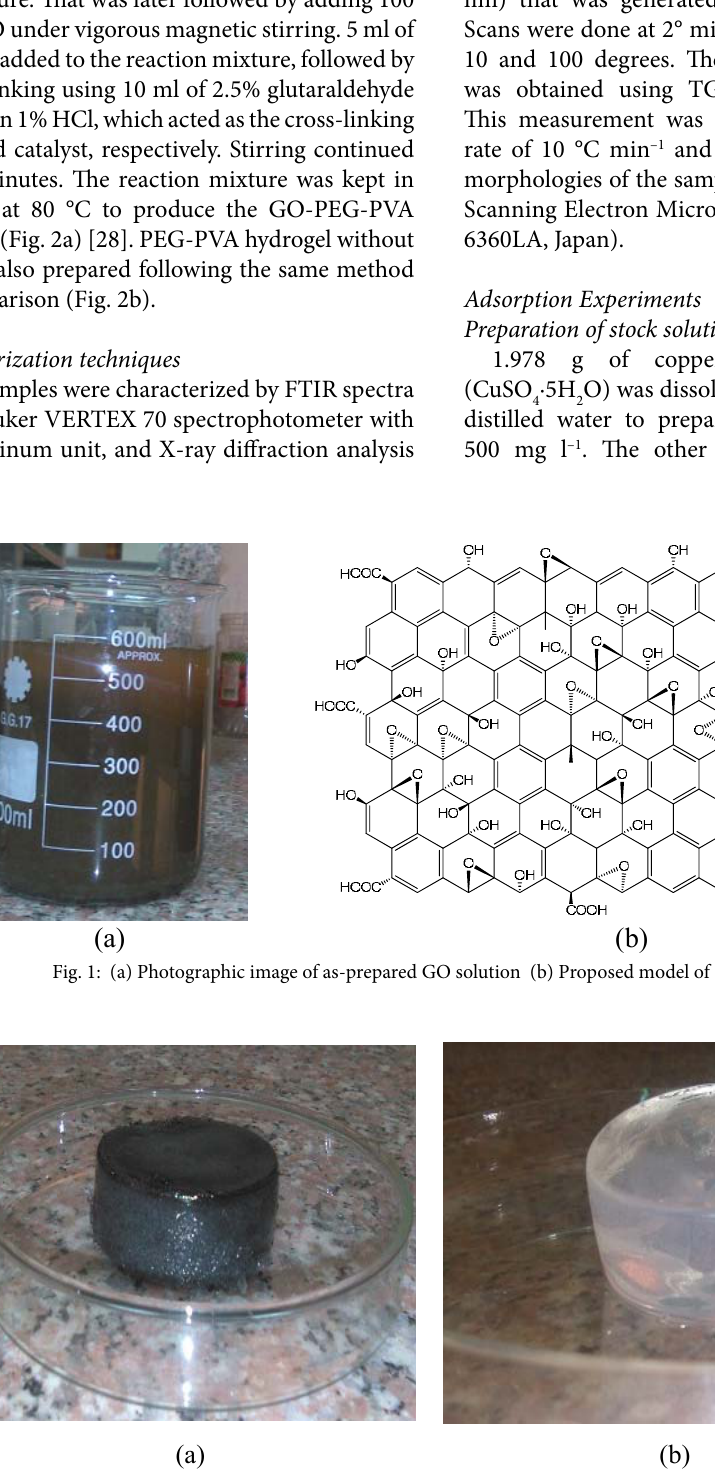
Fig. 2: (a) Photographic image of PVA-PEG-GO hydrogel (b) photographic image of PVA-PEG